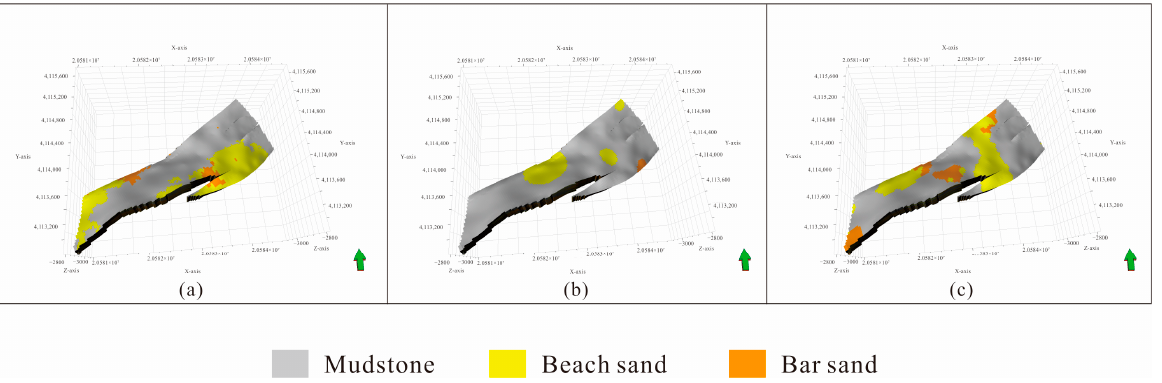
Figure 15. Beach-bar model established by common simulation methods. ( a ) Sequential indication simulation; ( b ) object-based simulation; ( c ) multipoint geostatistical simulation.